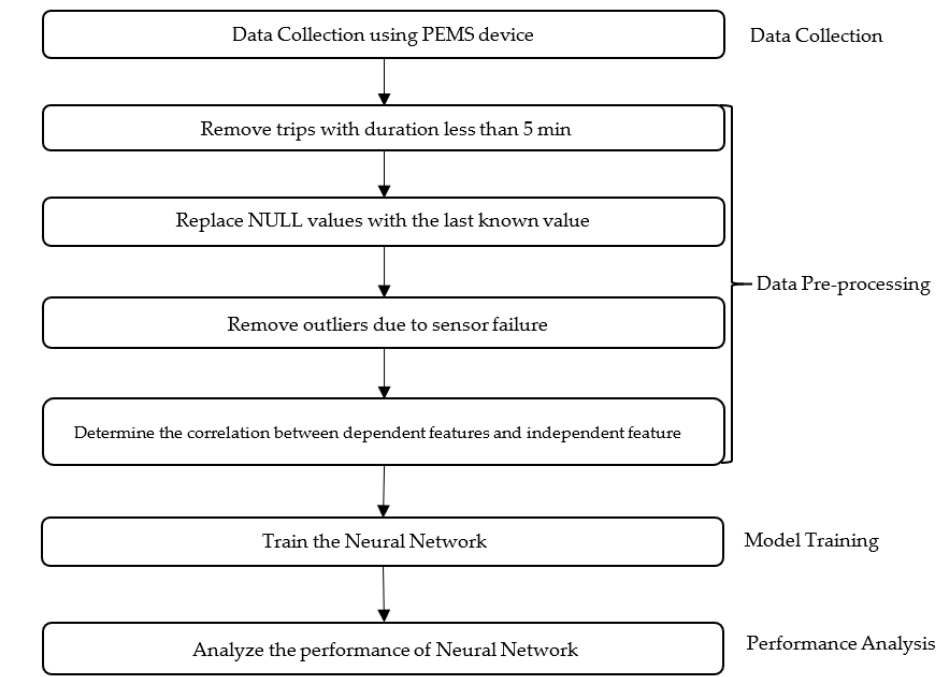
Figure 1. Workflow for fuel consumption modeling.